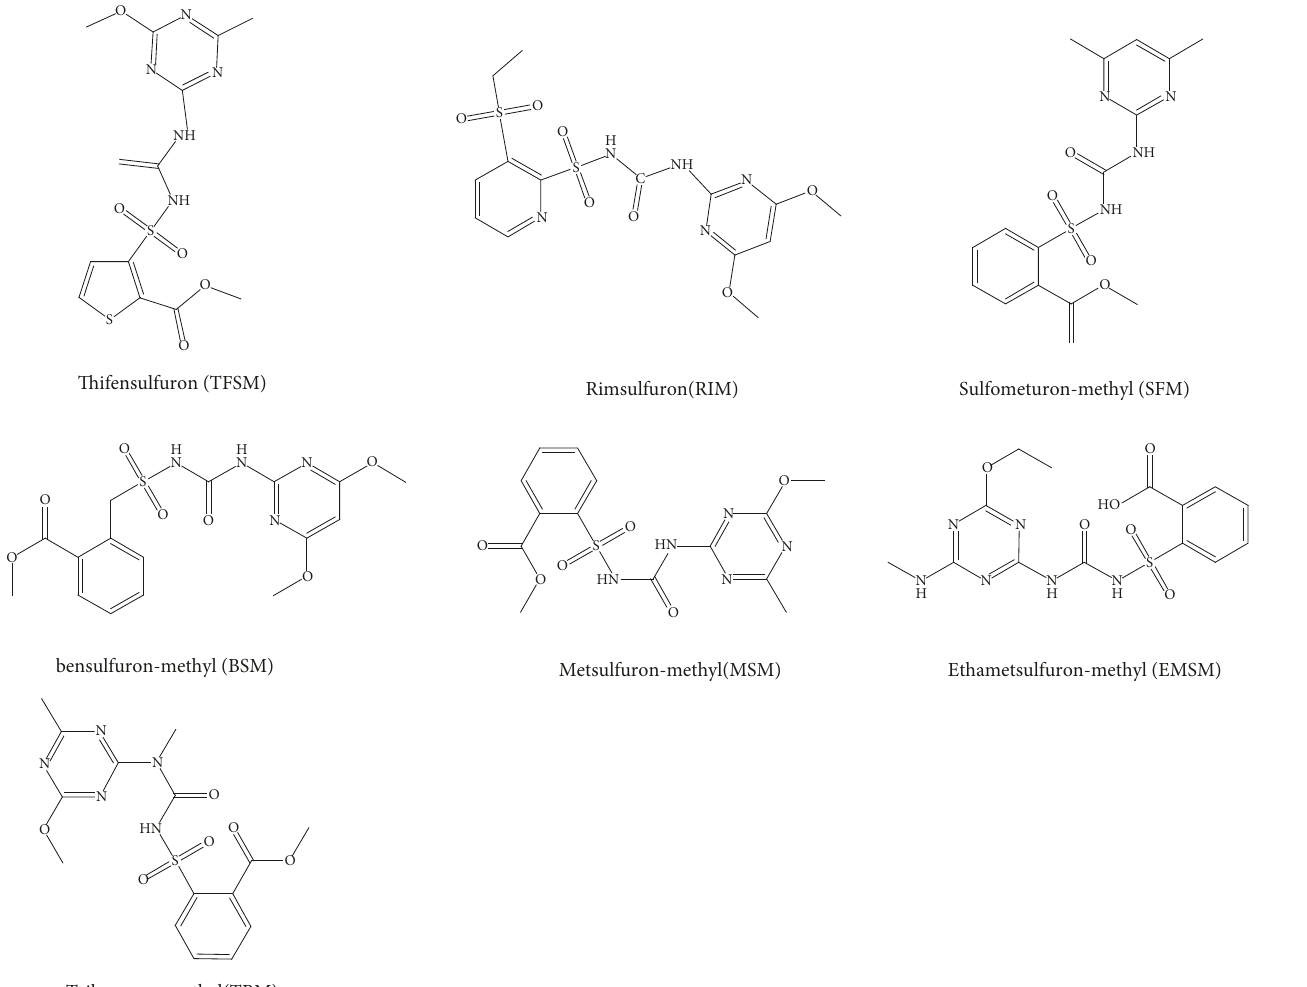
Figure 1: Chemical structure of tribenuron-methyl and analogues.